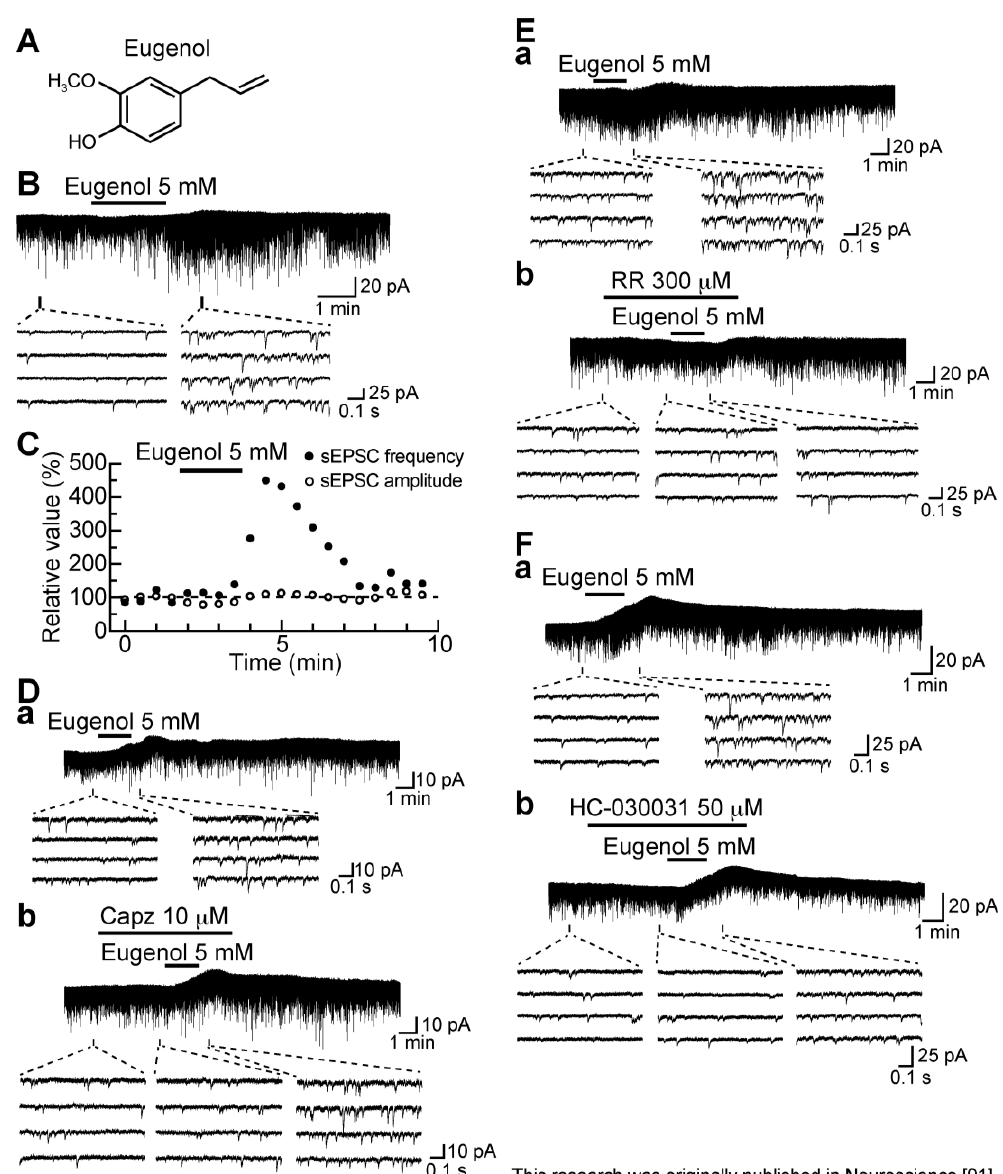
Figure 11. Eugenol (5 mM) enhances spontaneous excitatory transmission in rat SG neurons by TRPA1 but not TRPV1 activation. ( A ) The chemical structure of eugenol; ( B ) Recordings of sEPSCs in the absence and presence of eugenol. Eugenol produces a peak outward current of 6.4 pA; ( C ) Time courses of changes in sEPSC frequency and amplitude (closed and open circles, respectively) during the action of eugenol, relative to those before its superfusion (frequency and amplitude: 4.33 Hz and 13.8 pA, respectively), where they were measured every 0.5 min. ( B , C ) were obtained from the same neuron; ( D – F ) Recordings of sEPSCs under the action of eugenol in the absence ( a ) and presence ( b ) of Capz (10 µM; D ), RR (300 µM; E ) or HC-030031 (50 µM; F ). V = −70 mV. Modified from [91] with permission of Elsevier Science. H